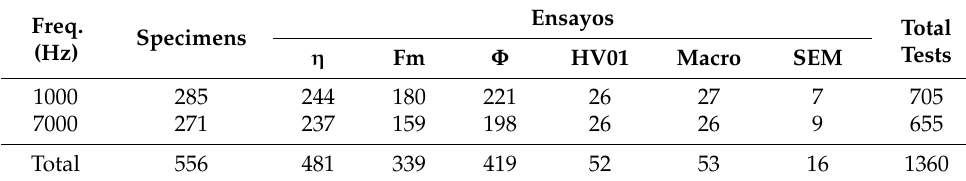
Table 2. Specimens